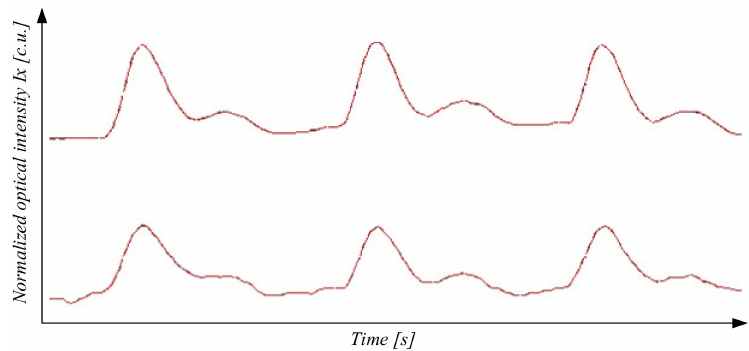
Figure 10. An example of deriving the results of the